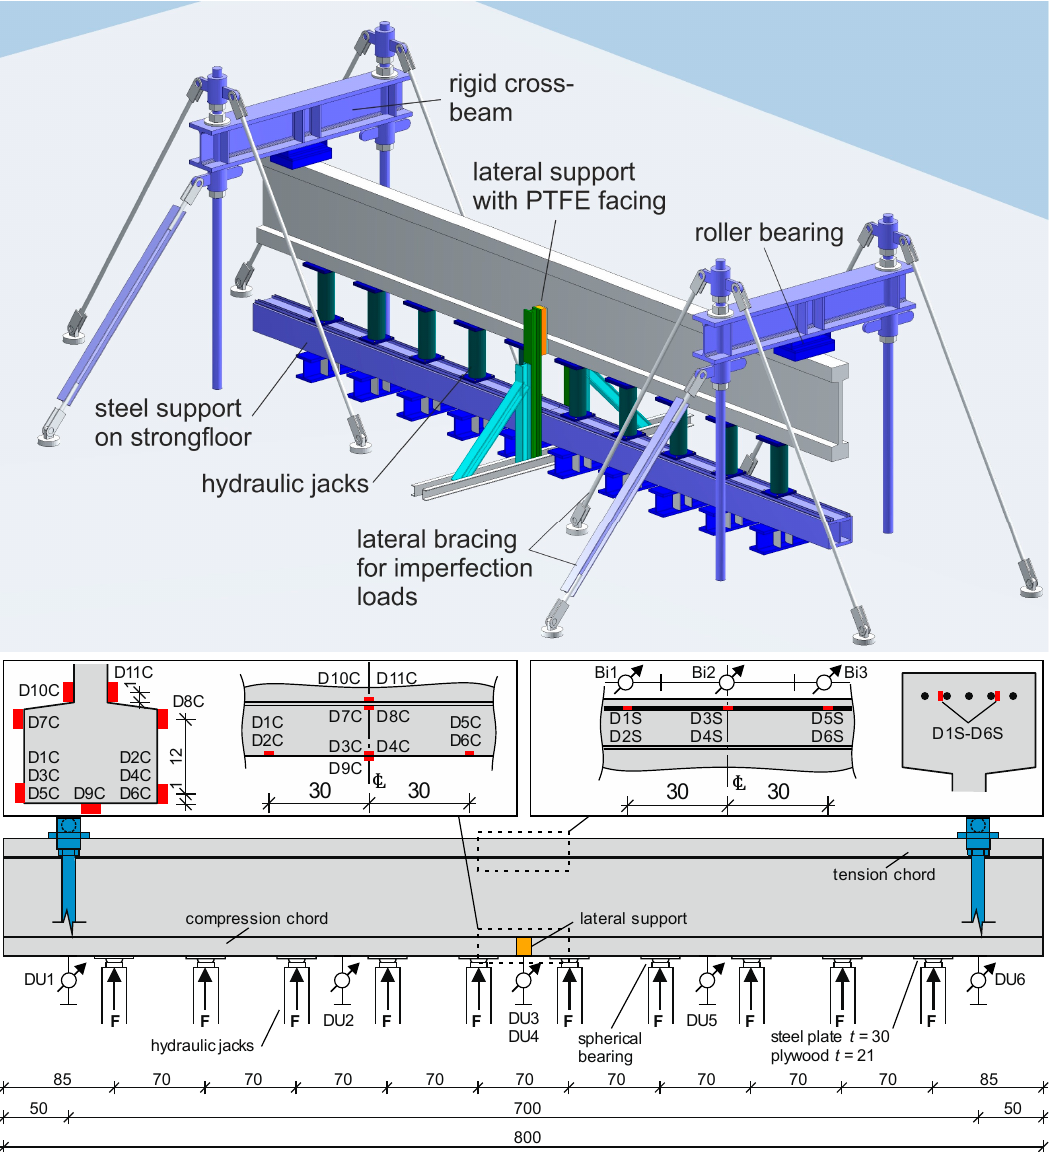
Figure 3. Test setup with continuous loading and instrumentation.